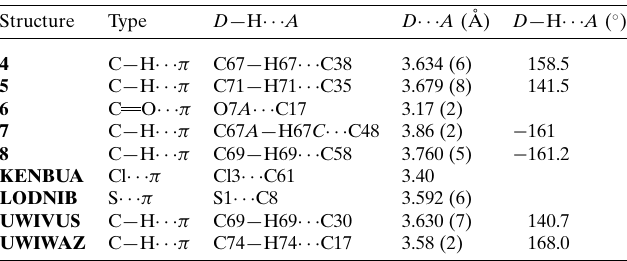
Table 2 Interaction metrics stabilizing inclusion compounds (motif I).